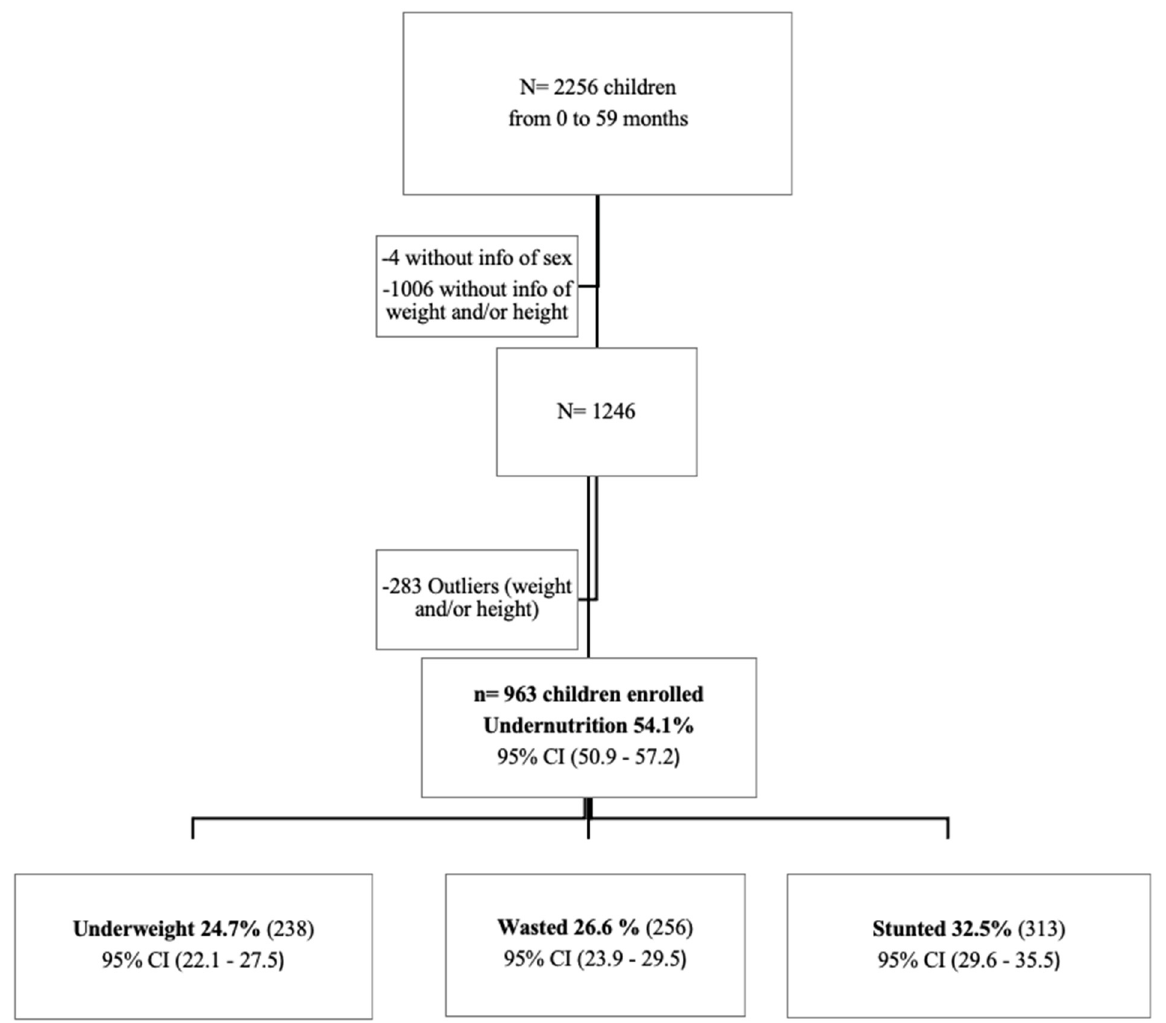
Figure 1. Flow diagram of children enrolled for the analysis and their nutritional status.